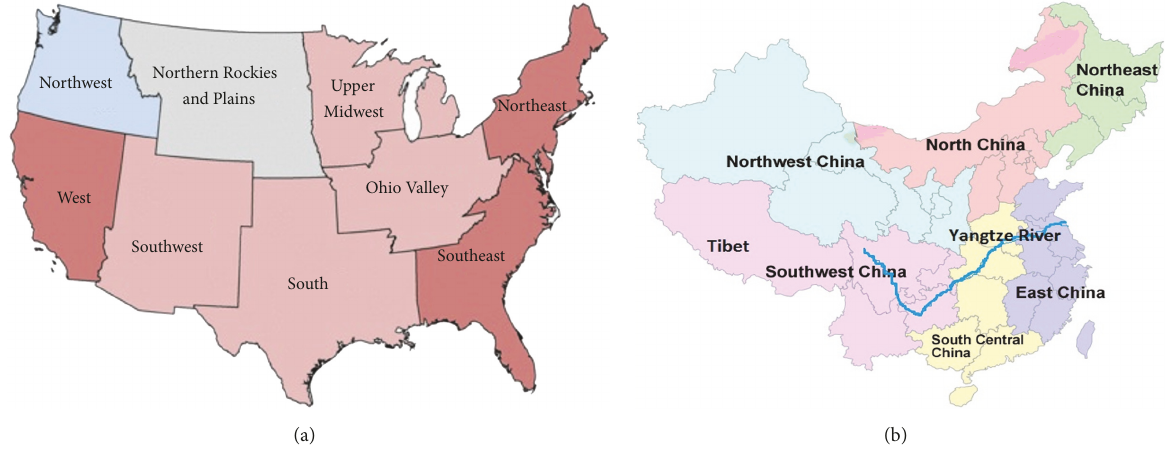
Figure 1: (a) Regions in the United States. (b) Regions in